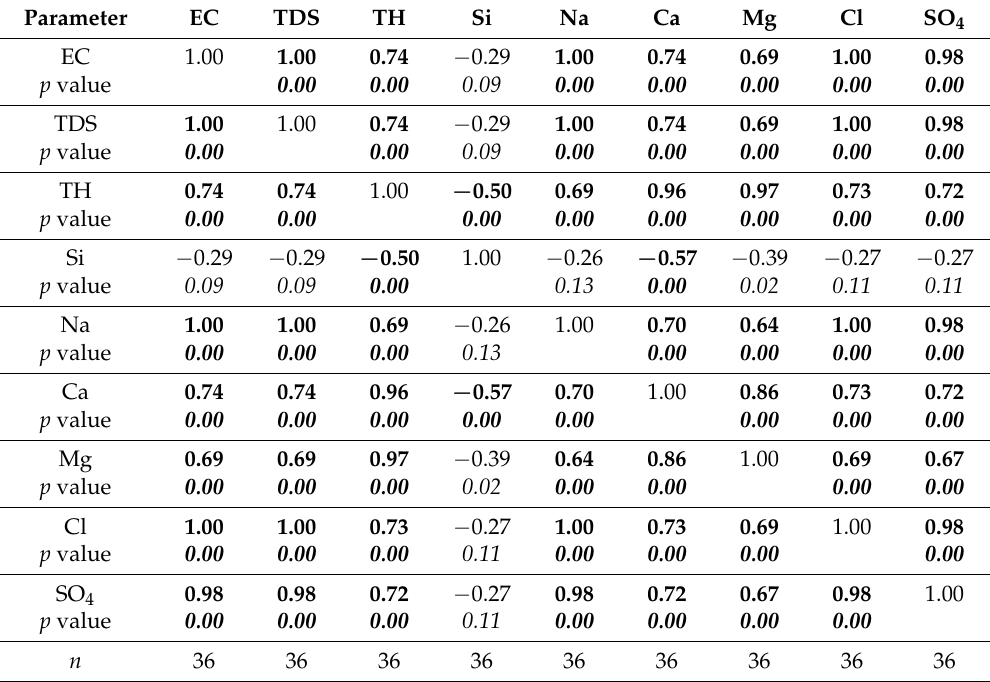
Table 2. Correlation among water quality